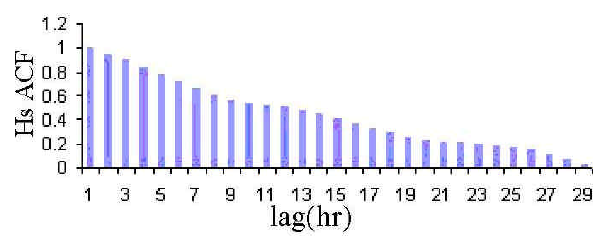
Figure12. Significant wave height auto correlation with 1hr time lag